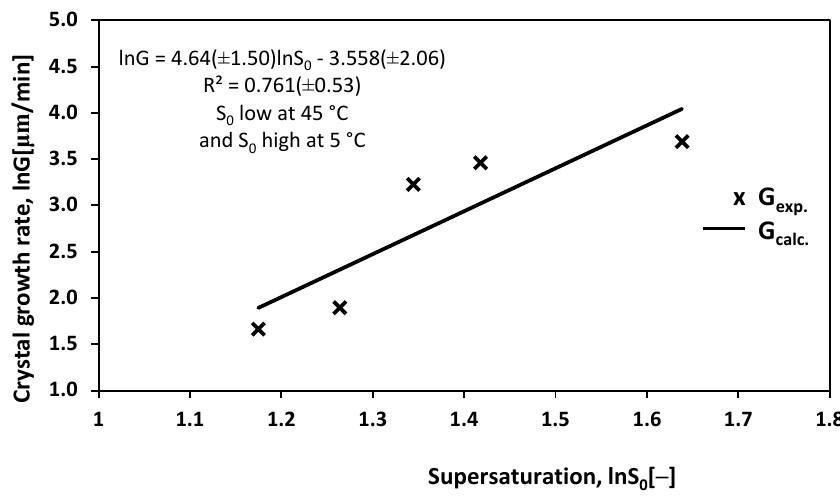
Figure 8. The fit of the empirical parameters g and k g .